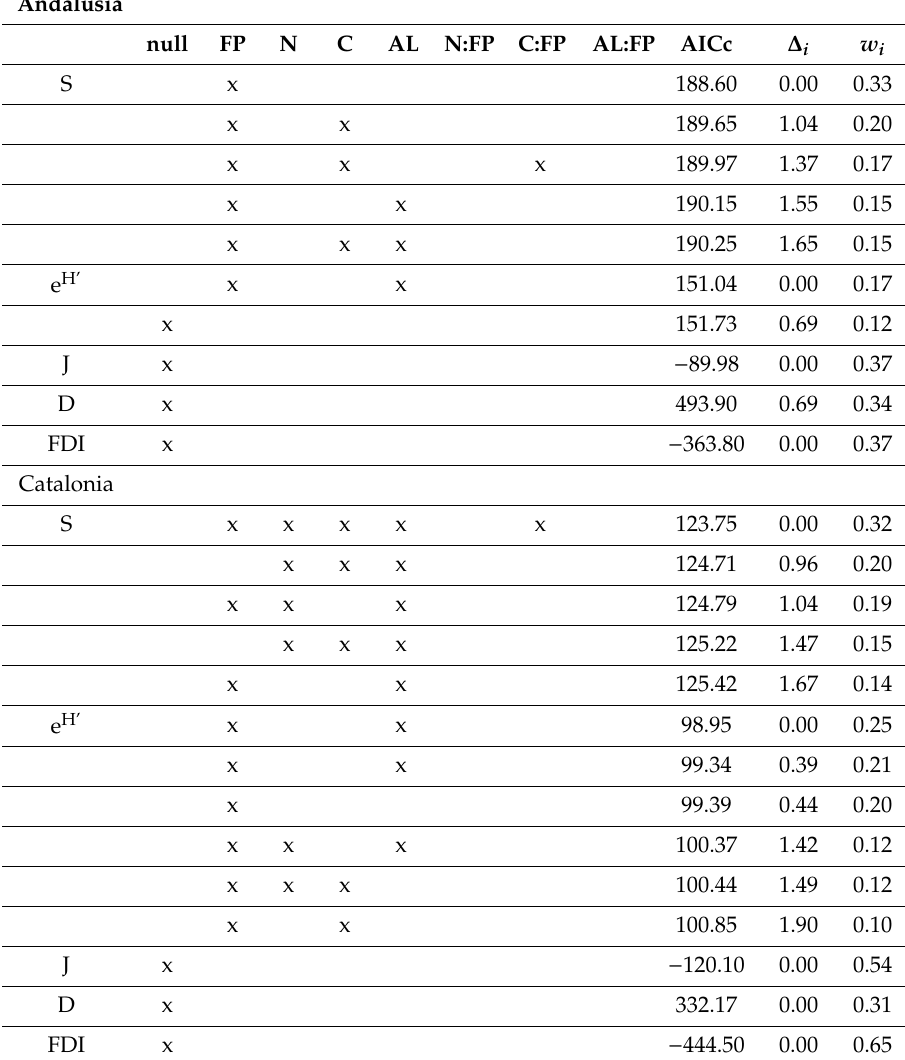
Table 4. The best set of submodels ( ∆ i < 2) to describe the number of seedlings (D), he taxonomic (S, e H’ and J) and the functional diversity (FDI) of the seedbanks in the cereal fields of Andalusia and Catalonia. Each row represents a submodel. Variables marked with x are those included in that model. Symbol “:” indicates interaction between variables. Corrected Akaike Information Criterion (AICc), Delta Akaike ( ∆ i ), and Akaike weights ( w i ) are shown for each submodel. Field position (FP); Organic Nitrogen (N); Percentage clay, (C); Arable land cover (AL). Andalusia null AL N:FP